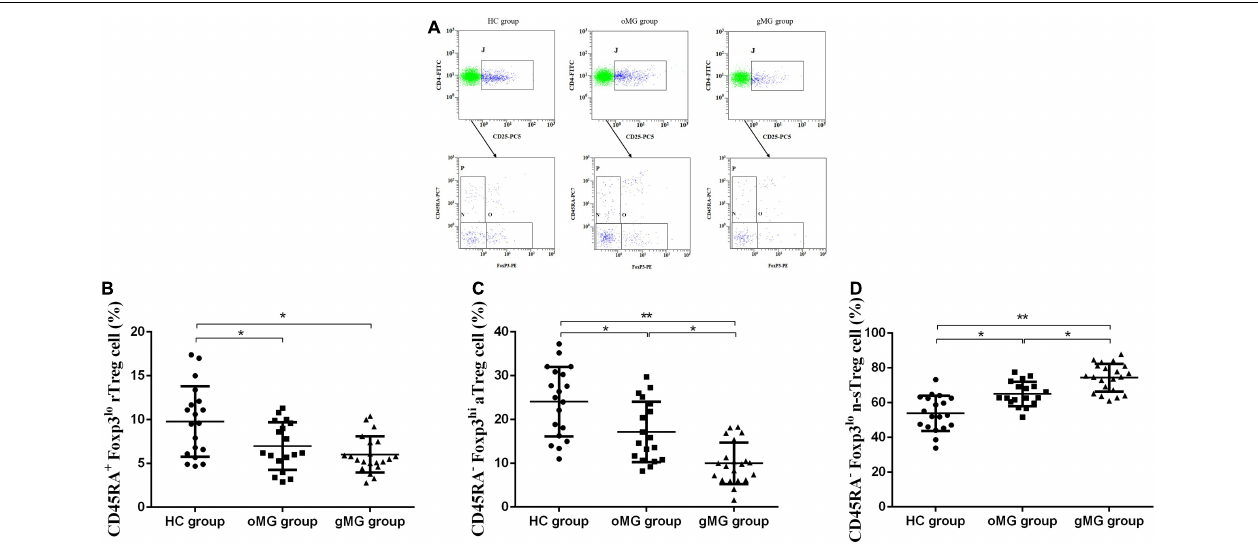
FIGURE 3 | Different expression of Treg functional subsets in peripheral blood of patients with MG (oMG: n = 18, gMG: n = 21) and HCs ( n = 19). (A) Representative flow cytometry plots of Treg functional subsets in HCs and MG patients. (B) Comparison of the frequency of CD3 + CD4 + CD25 + Foxp3 lo CD45RA + rTreg cells between HCs and MG patients. (C) Comparison of the frequency of CD3 + CD4 + CD25 + Foxp3 hi CD45RA − aTreg cells between MG patients and HCs. (D) Representative flow cytometry plots of CD3 + CD4 + CD25 + Foxp3 lo CD45RA − n-sTreg cells in HCs and MG patients. The results are expressed as the Mean ± SD of three independent experiments (* p < 0.05, ** p <